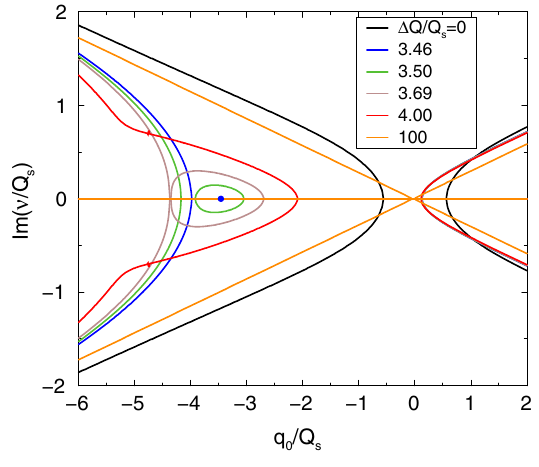
FIG. 3. Imaginary part of the boxcar eigentunes against the wake strength at different values of the space charge tune shift. There are two regions of instability if the wake is negative and 3 . 46 < Δ Q=Q s < 3 . 69